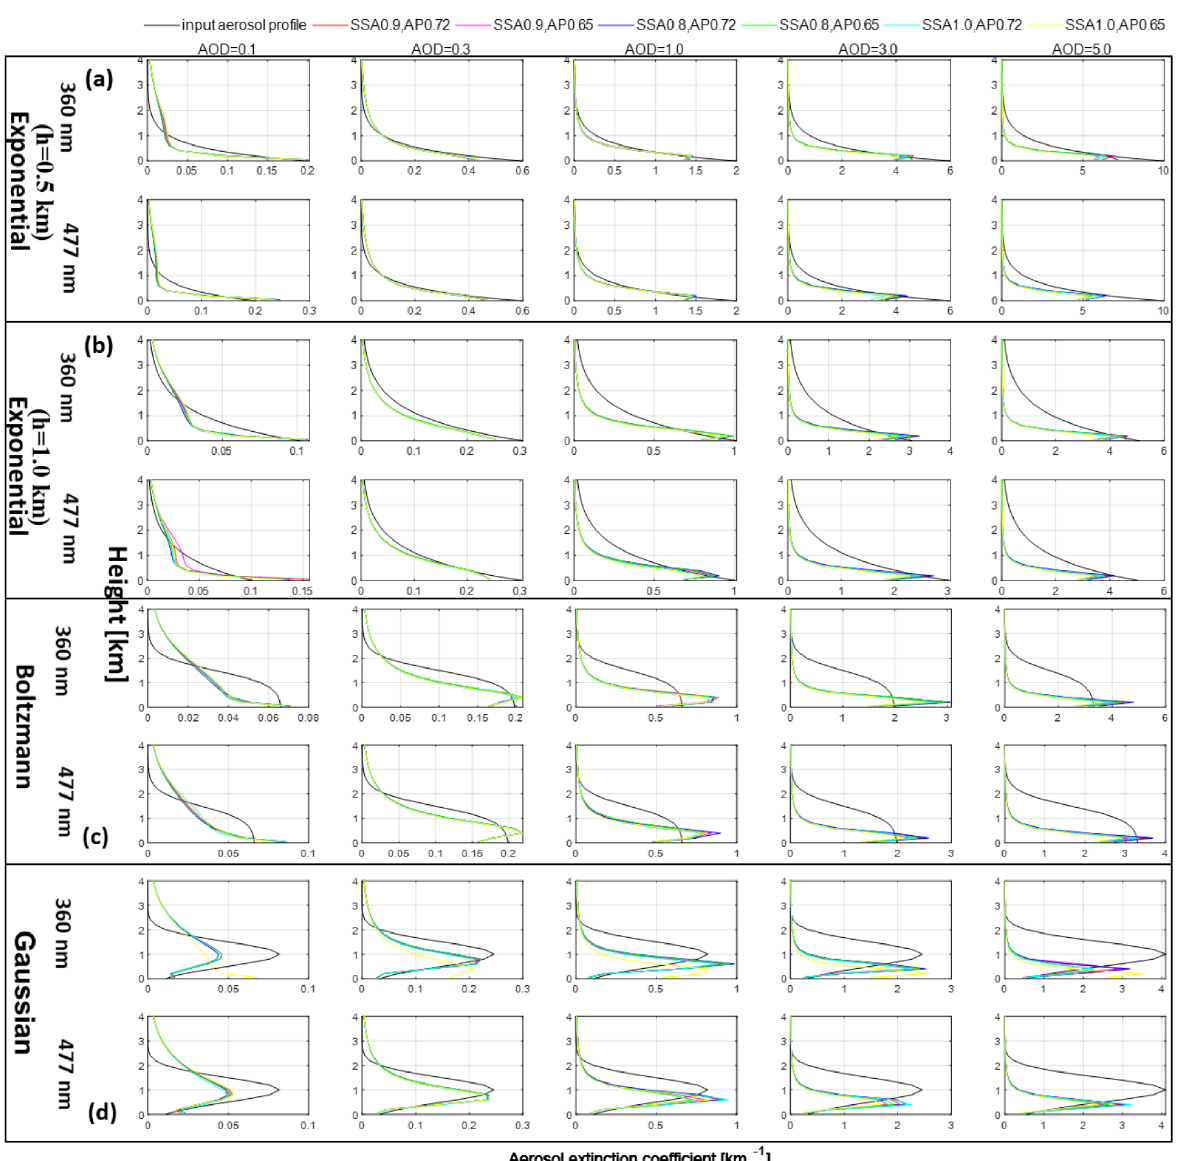
Figure 9. Retrieved aerosol profiles by PriAM using different SSA and AP for (a) exponential shape with h = 0.5km, (b) exponential shape with h = 1.0km, (c) Boltzmann shape, and (d) Gaussian shape. For these inversions, the same SSA and AP were used for the simulations of the O 4 DSCDs and for the PriAM inversions. The first line in every panel denotes the results for 360nm, and the second line denotes the results for 477nm. The colors refer to the corresponding SSA and AP values shown at the